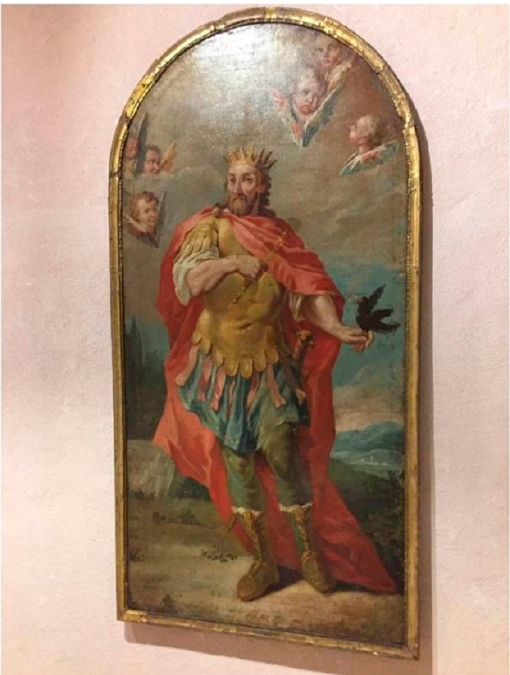
Figure 10. Saint Oswald, Giovanni Venanzi, 1700 ca., Cathedral of Saint Tryphon, Kotor, photo by author.